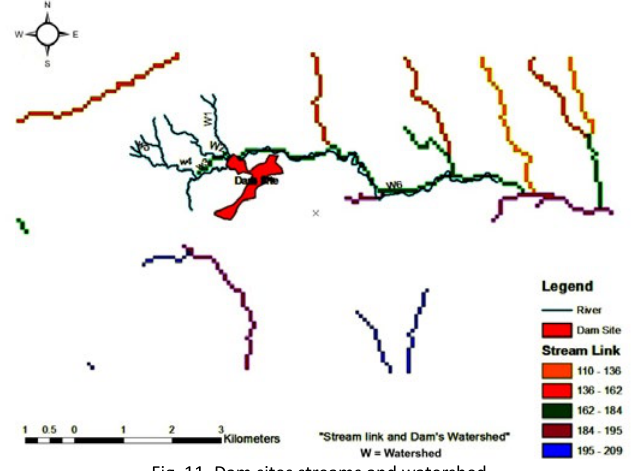
Fig. 11. Dam sites streams and watershed Fig. 11: Dam sites streams and watershed